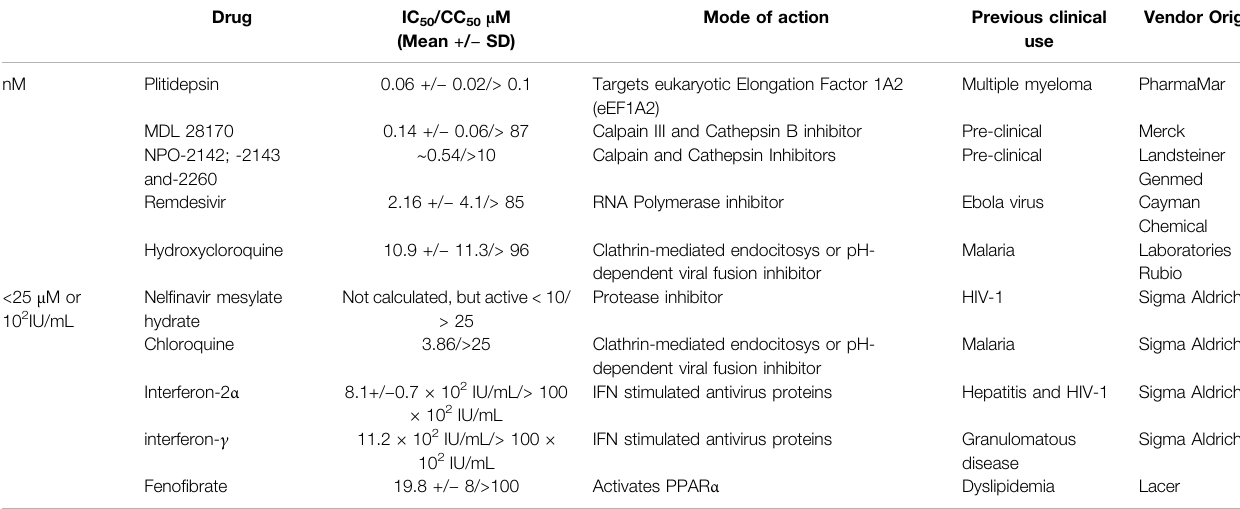
TABLE 1| Compounds with antiviral activity ordered depending on their IC 50 values on VeroE6. Notice that plitidepsin and cathepsininhibitorsdisplay IC 50 values in the nM range, while the rest of the compounds are in the µM or 10 2 IU/ml